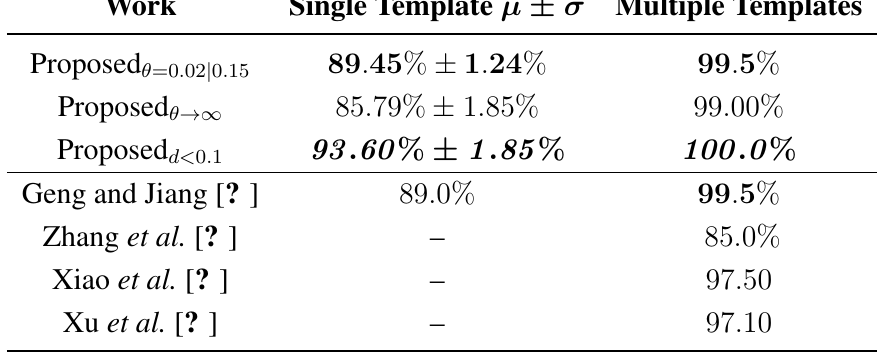
Table 1. Comparison between the obtained r state-of-the-art algorithms.